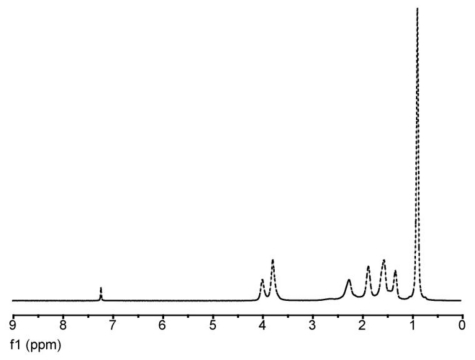
Representative 1H-NMR spectral scan for B3 copolymer.